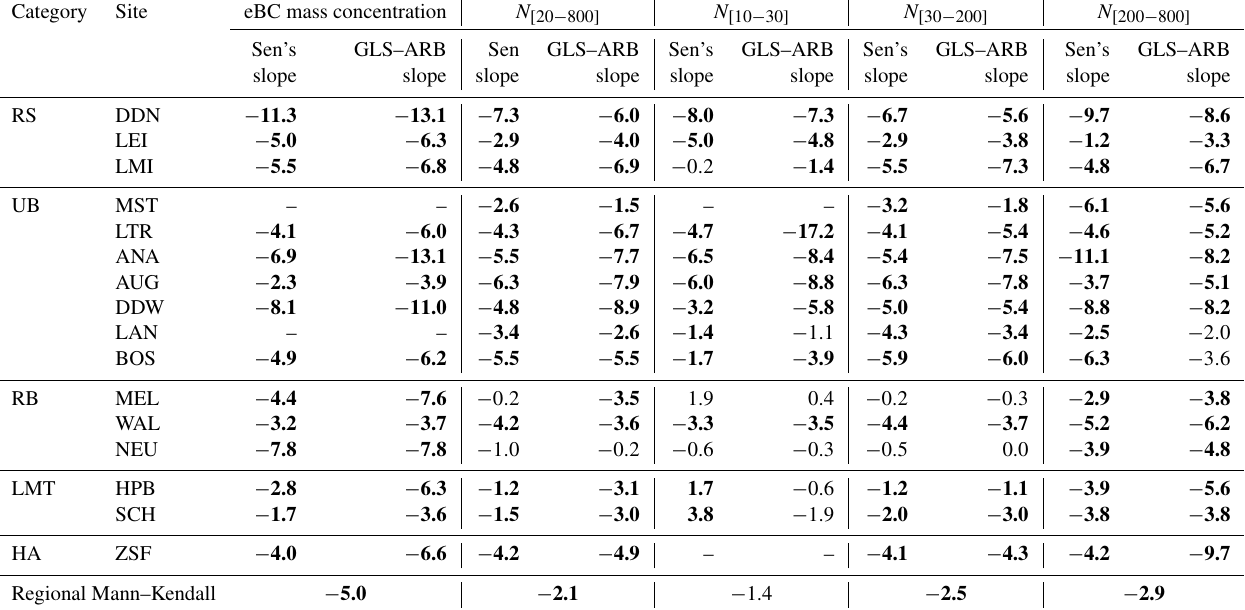
Table 3. Multi-annual trends of the PNCs and eBC mass concentration in percentage per year, calculated using the customised Sen’s estimator and generalised least-square regression with autoregression bootstrap (GLS–ARB). Statistically significant slopes at the 95% significance level are marked as bold numbers. Five site categories in the left column are roadside (RS), urban background (UB), regional background (RB), low mountain range (LMT), and high Alpine